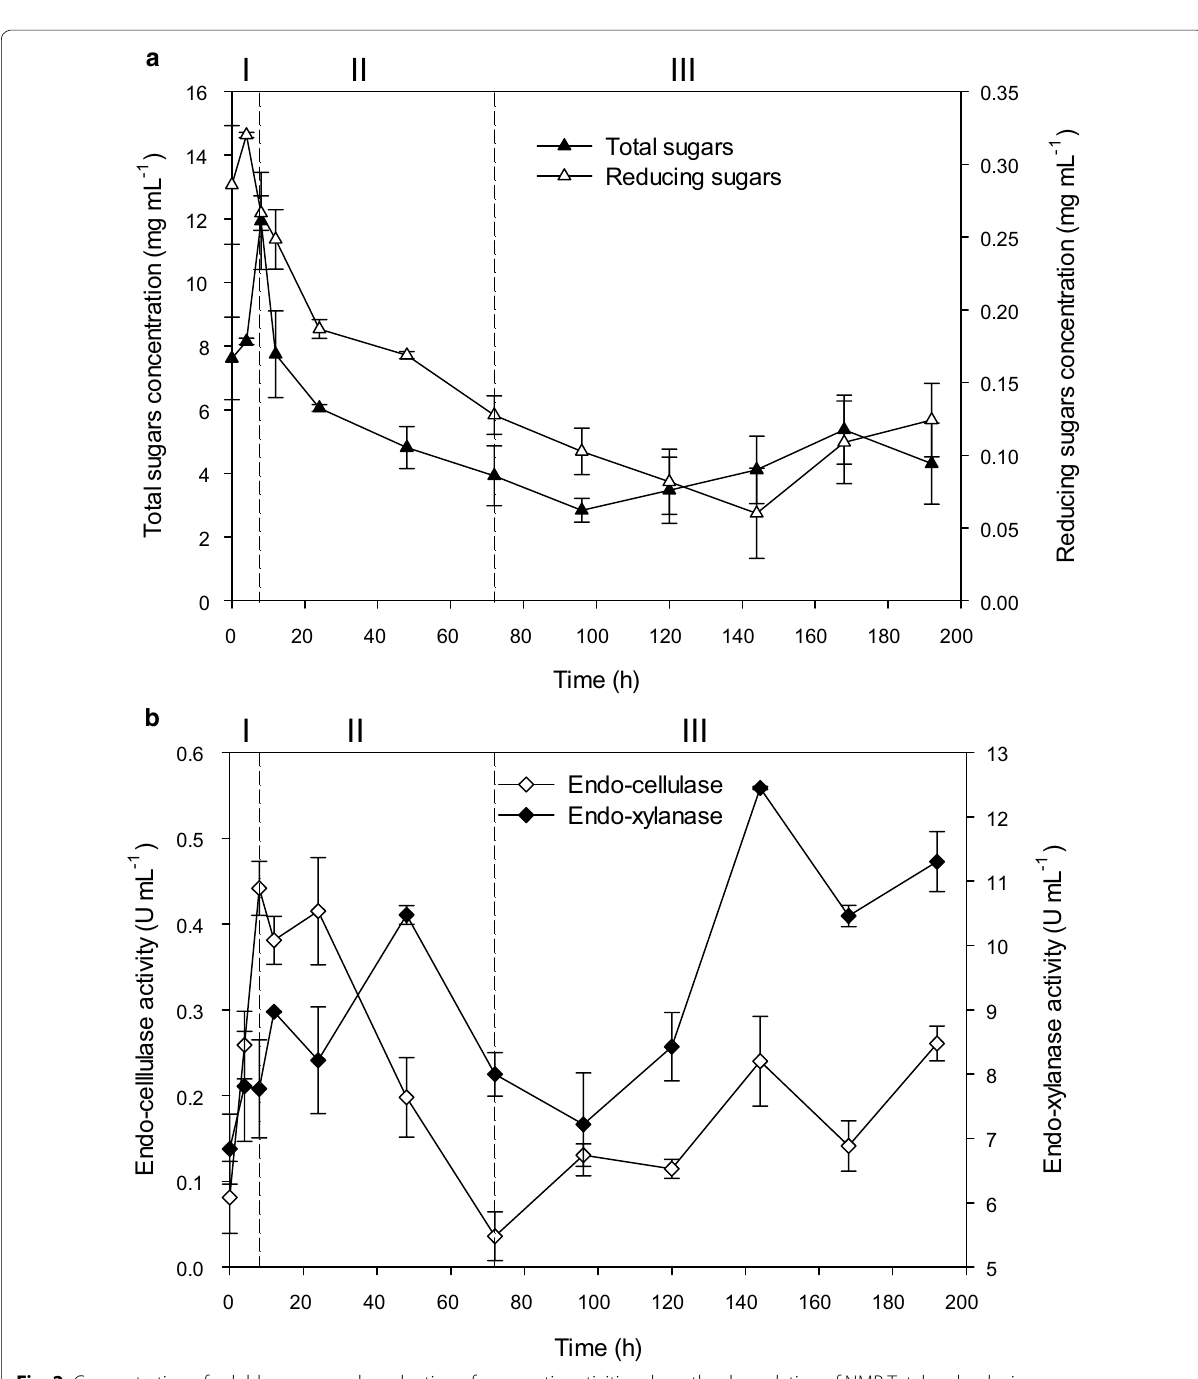
Fig. 2 Concentration of soluble sugars and production of enzymatic activities along the degradation of NMP. Total and reducing sugars concentration ( a ). Endo‑xylanase and endo‑cellulase activities ( b